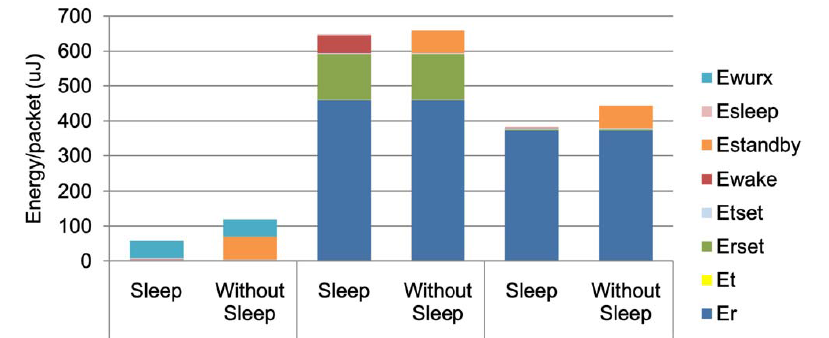
Figure 5. Importance of WuR in IBSN